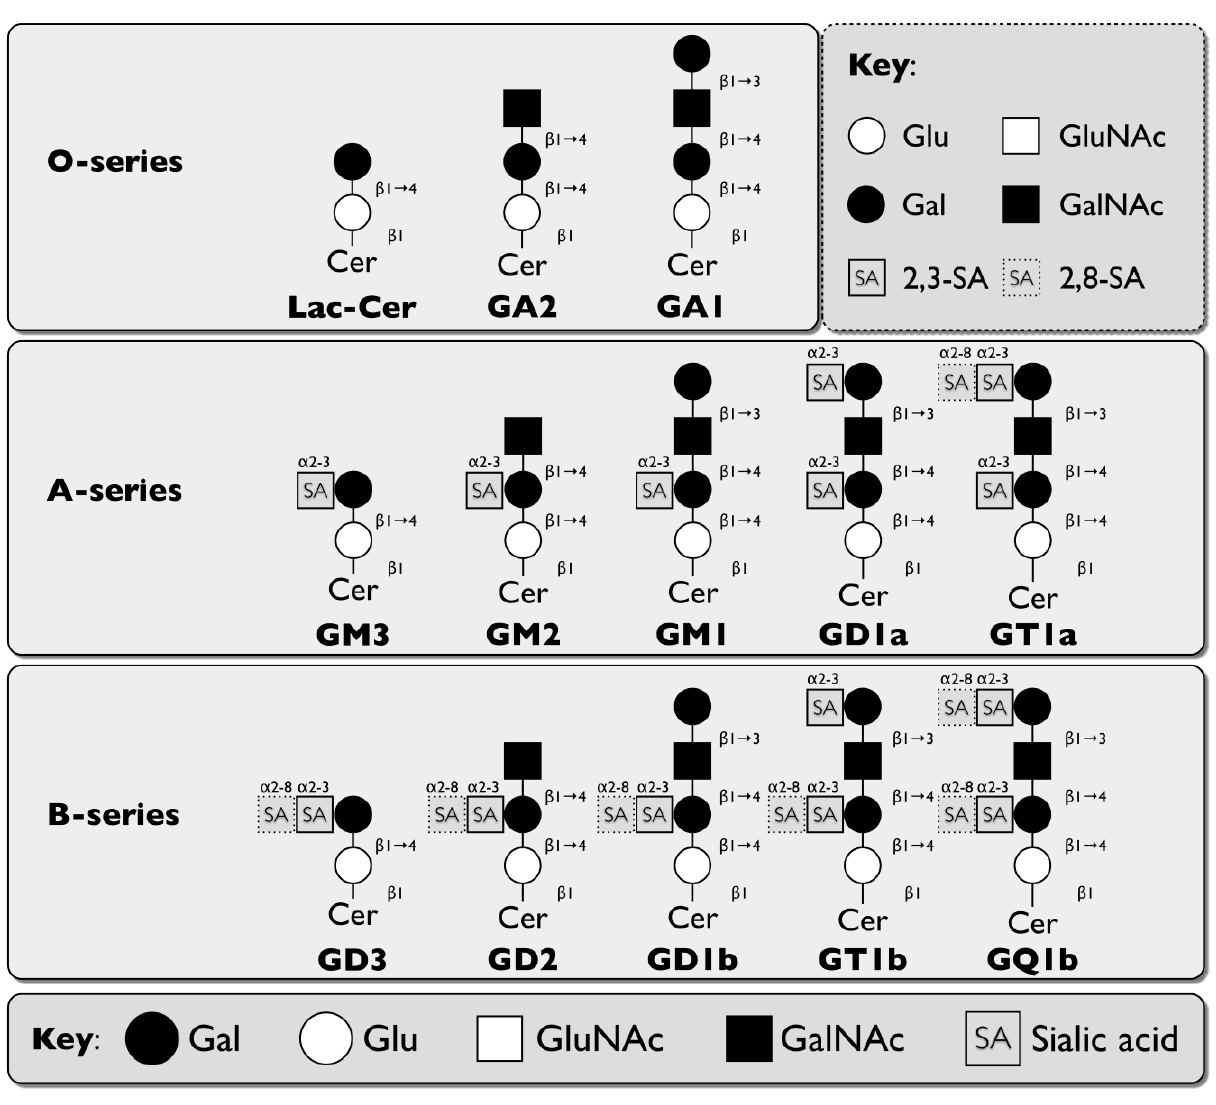
Figure 5. Schematic overview of O-, A- and B-series gangliosides discussed in text. Abbreviations: Glu: glucose, Gal: galactose, GluNAc: N-acetylglucosamine, GalNAc: N-acetylgalactosamine, Cer: ceramide, R: